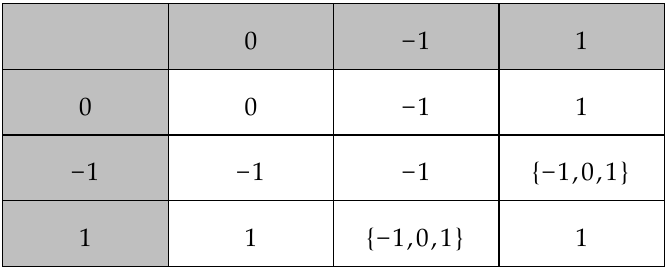
Table 4. The Cayley table of the canonical hypergroup of the hyperfield F / F +